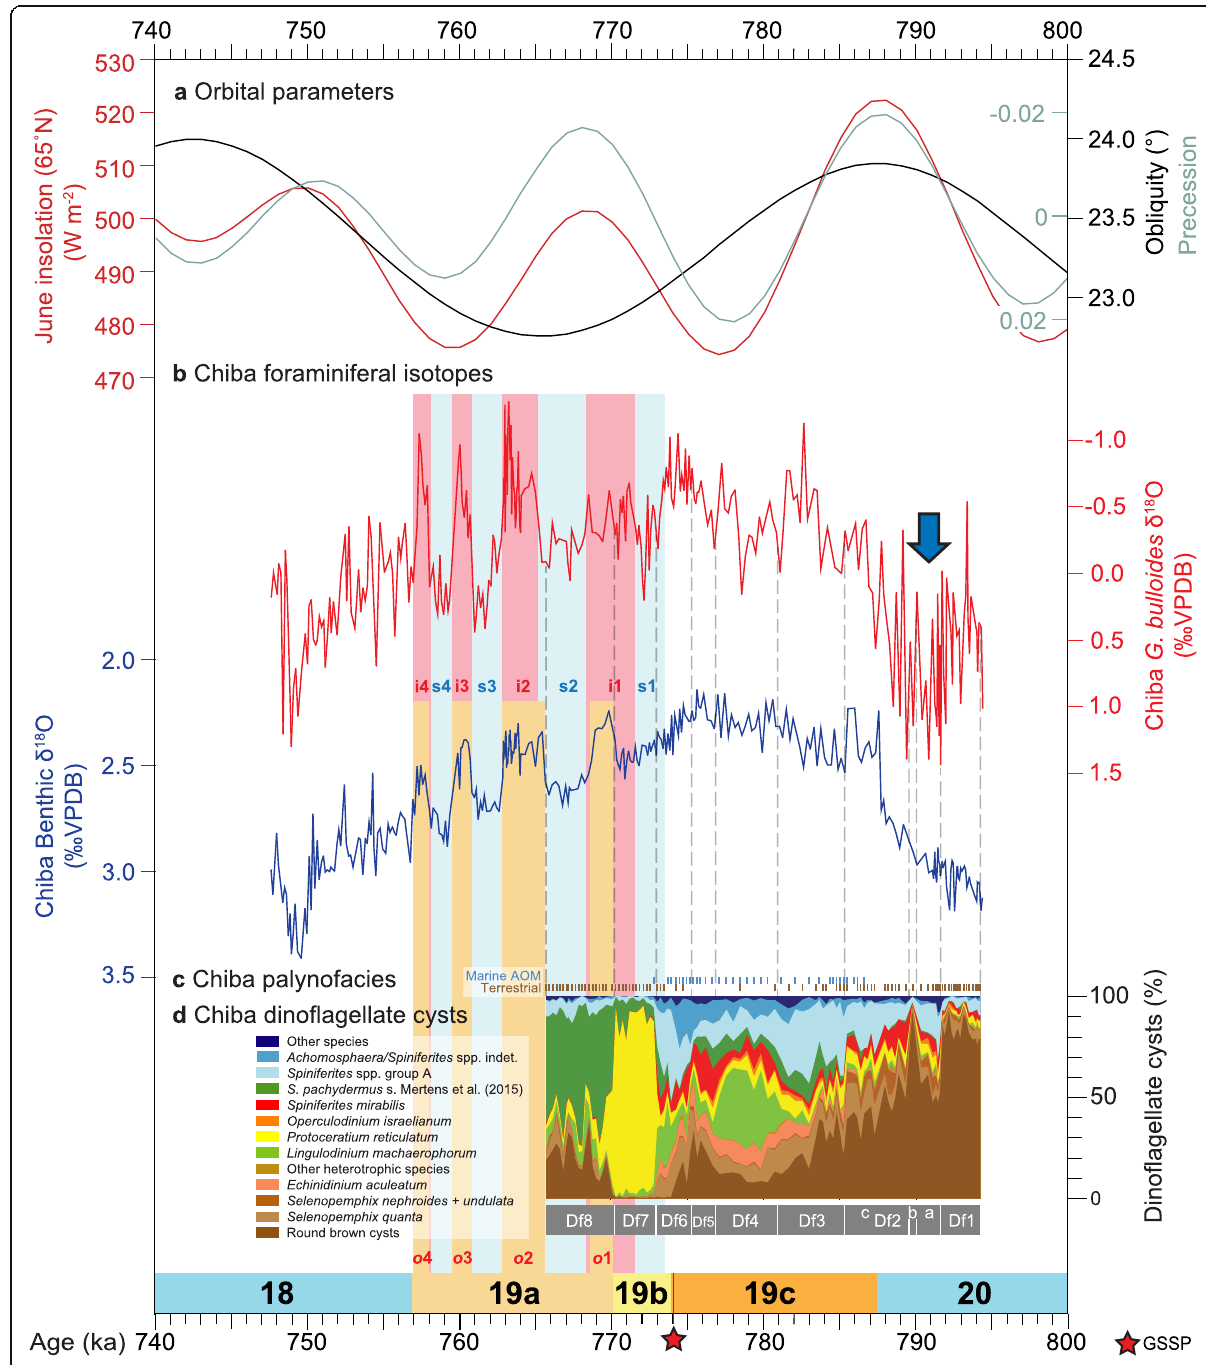
Fig. 18 Dinoflagellate cyst synthetic diagram (this study) compared with the foraminiferal δ 18 O records of the Chiba composite section. a Insolation at 65°N in June, and precession and obliquity parameters (Laskar et al. 2004). b Planktonic ( G. bulloides ) and benthic foraminiferal δ 18 O records of the Chiba composite section (Haneda et al. 2020b) based on the age model of Suganuma et al. (2018). c Dominant palynofacies component (brown line, terrestrial; blue line, marine amorphous organic matter [AOM]) from Fig. 16. d Dinoflagellate cyst synthetic diagram showing the most abundant taxa and local assemblage biozonation (this study). Substage classification of MIS 19 with stadials (MIS 19-s1 – s4) and interstadials (MIS 19-i1 – i4) follows Haneda et al. (2020b) but with modified labeling and MIS 19a benthic isotope oscillations (MIS 19a- o 1 to MIS 19a- o 4) following Head (2021). Blue arrow marks the suggested position of a Younger Dryas-type cooling event according to Suganuma et al.